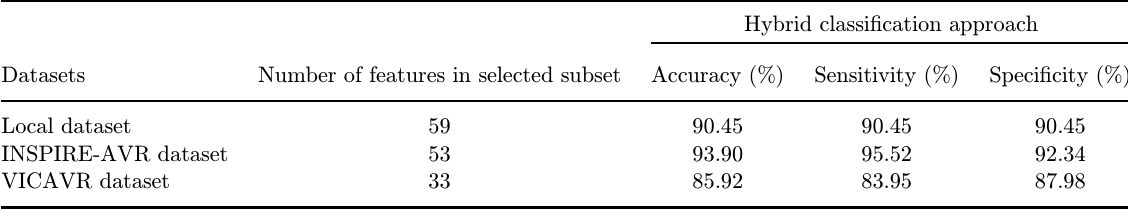
Table 6. Performance of hybrid classi¯cation for feature subsets acquired using relief-F